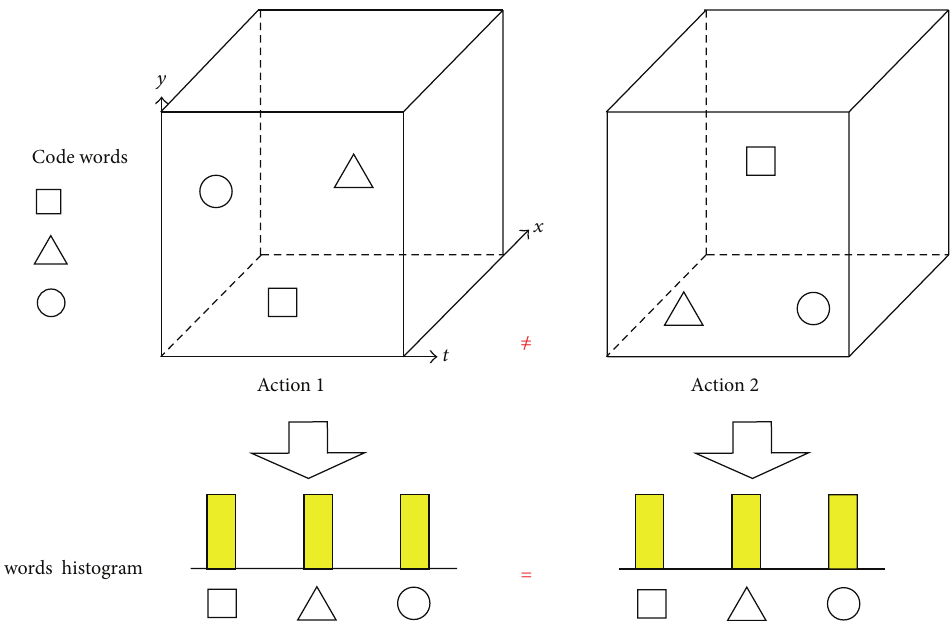
Figure 1: The illustration of that BoF ignores the spatiotemporal relationship of local features in STV. There are two groups of similar features with different spatiotemporal arrangements in STV. They are form Action 1 and Action 2, respectively. However, they cannot be correctly classified with BoF, because it obtains two same code words histograms due to ignoring feature spatiotemporal